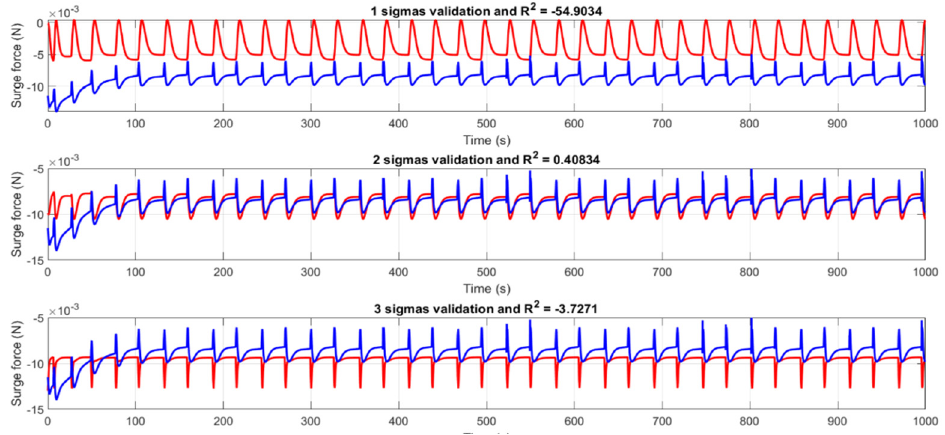
Figure 6. Results from the validation for surge motion with a 20 ◦ − 20 ◦ zigzag manoeuvre.